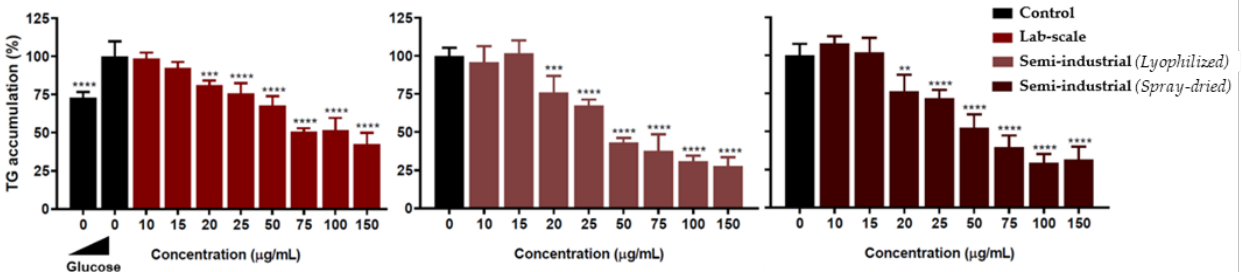
Figure 8. Triglyceride accumulation levels after AdipoRed™ staining. Undifferentiated control with low glucose is only shown in the left panel. Statistical significance was calculated using the high glucose-treated sample (full mature adipocytes) as a reference (* p < 0.05, ** p < 0.01, *** p < 0.001, and **** p < 0.0001).